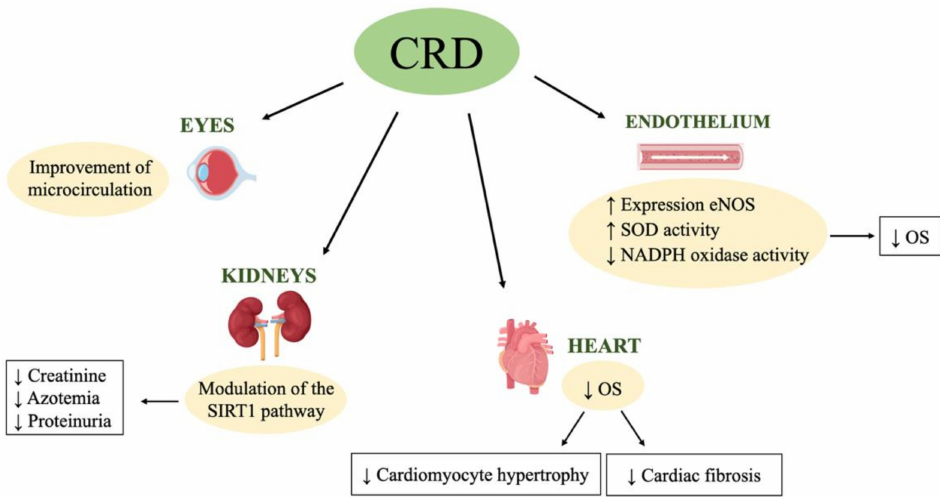
Figure 3. Improvement of caloric restriction diet on hypertensive organ damage. CRD, caloric restriction diet; eNOS, endothelial nitric oxide synthase; NADPH, nicotinamide adenine dinucleotide phosphate hydrogen; OS, oxidative stress; SIRT1, sirtuin 1; SOD, superoxide dismutase, ↑ increase, ↓